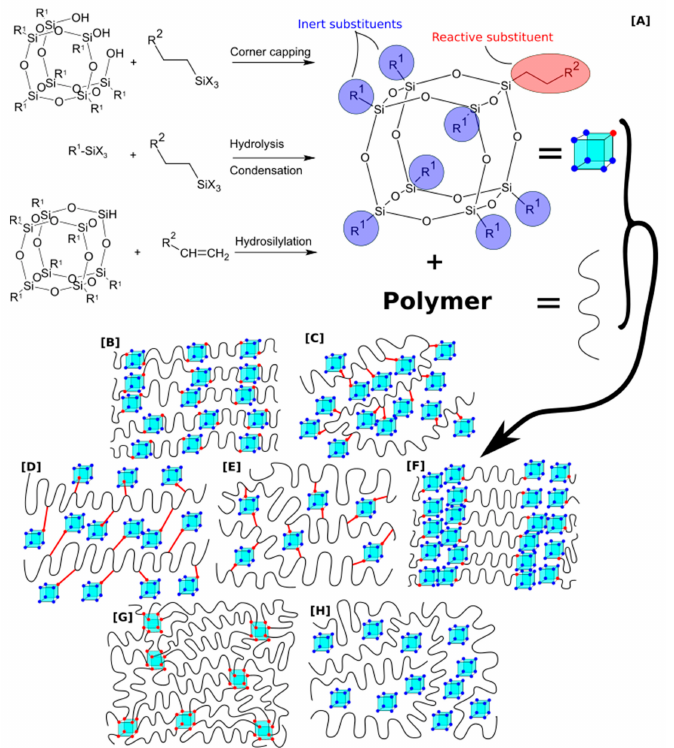
Figure 1. The scheme of POSS synthesis and incorporation into polymer matrices. ( A ) Most popular reactions, ( B – H ) various ways of incorporation of POSS, ( B ) pendant, ( C ) crosslinker, ( D ) bead-like, ( E ) physical blend, ( F ) telomeric, ( G ) net nodes, ( H )